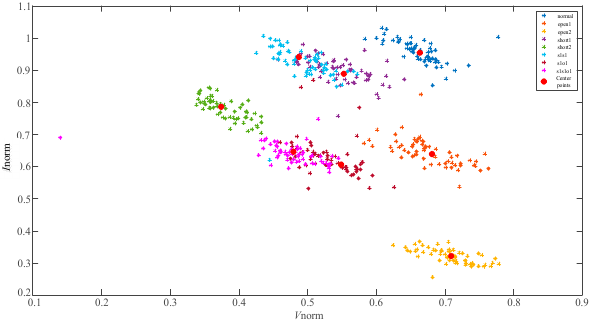
, V I in the field experiment. norm norm